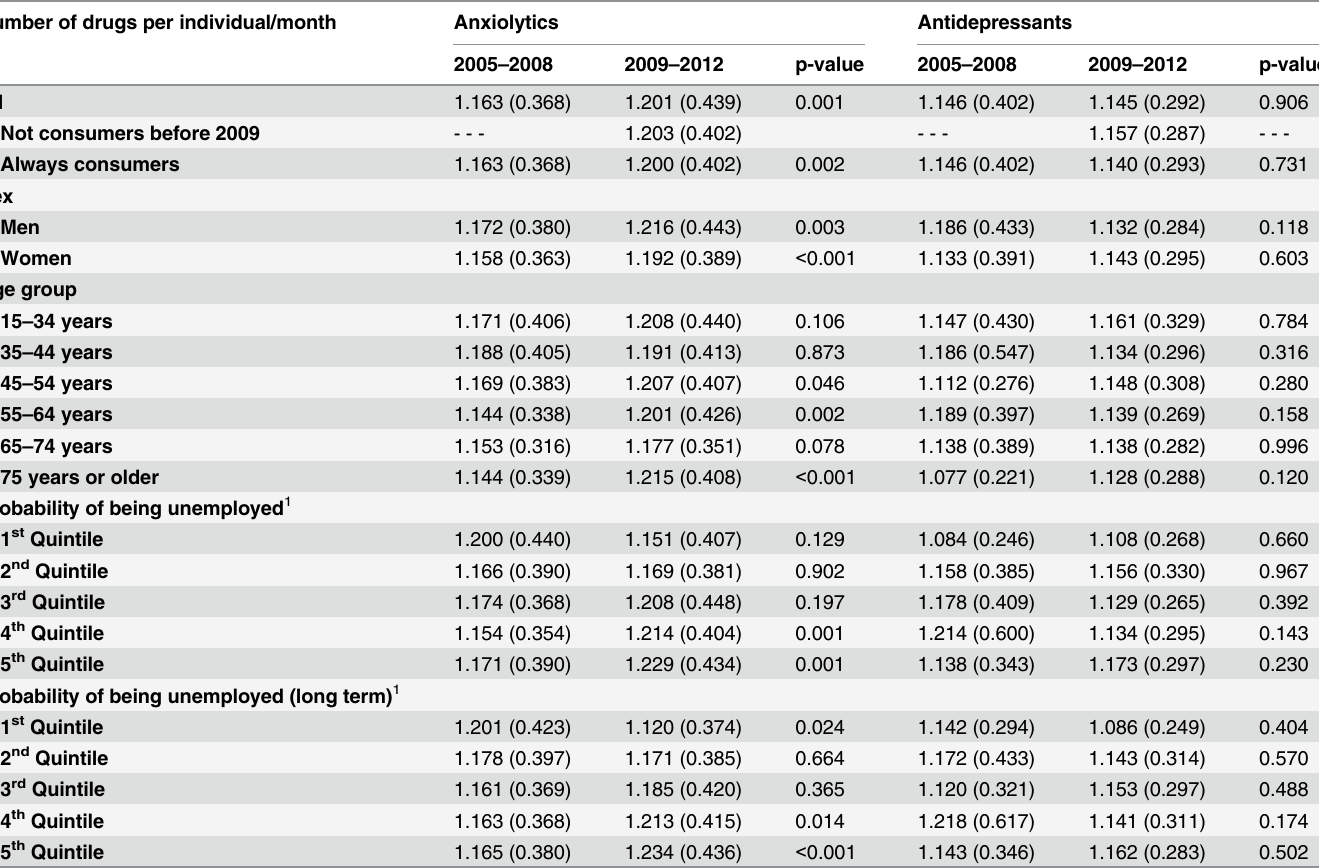
Table 4. Consumption of psychotropic drugs. Number of drugs per